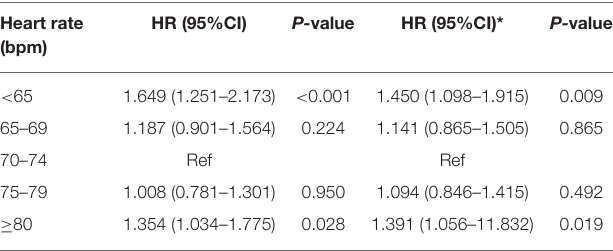
TABLE 2 | Association between heart rate and MACE risks in all hypertensive